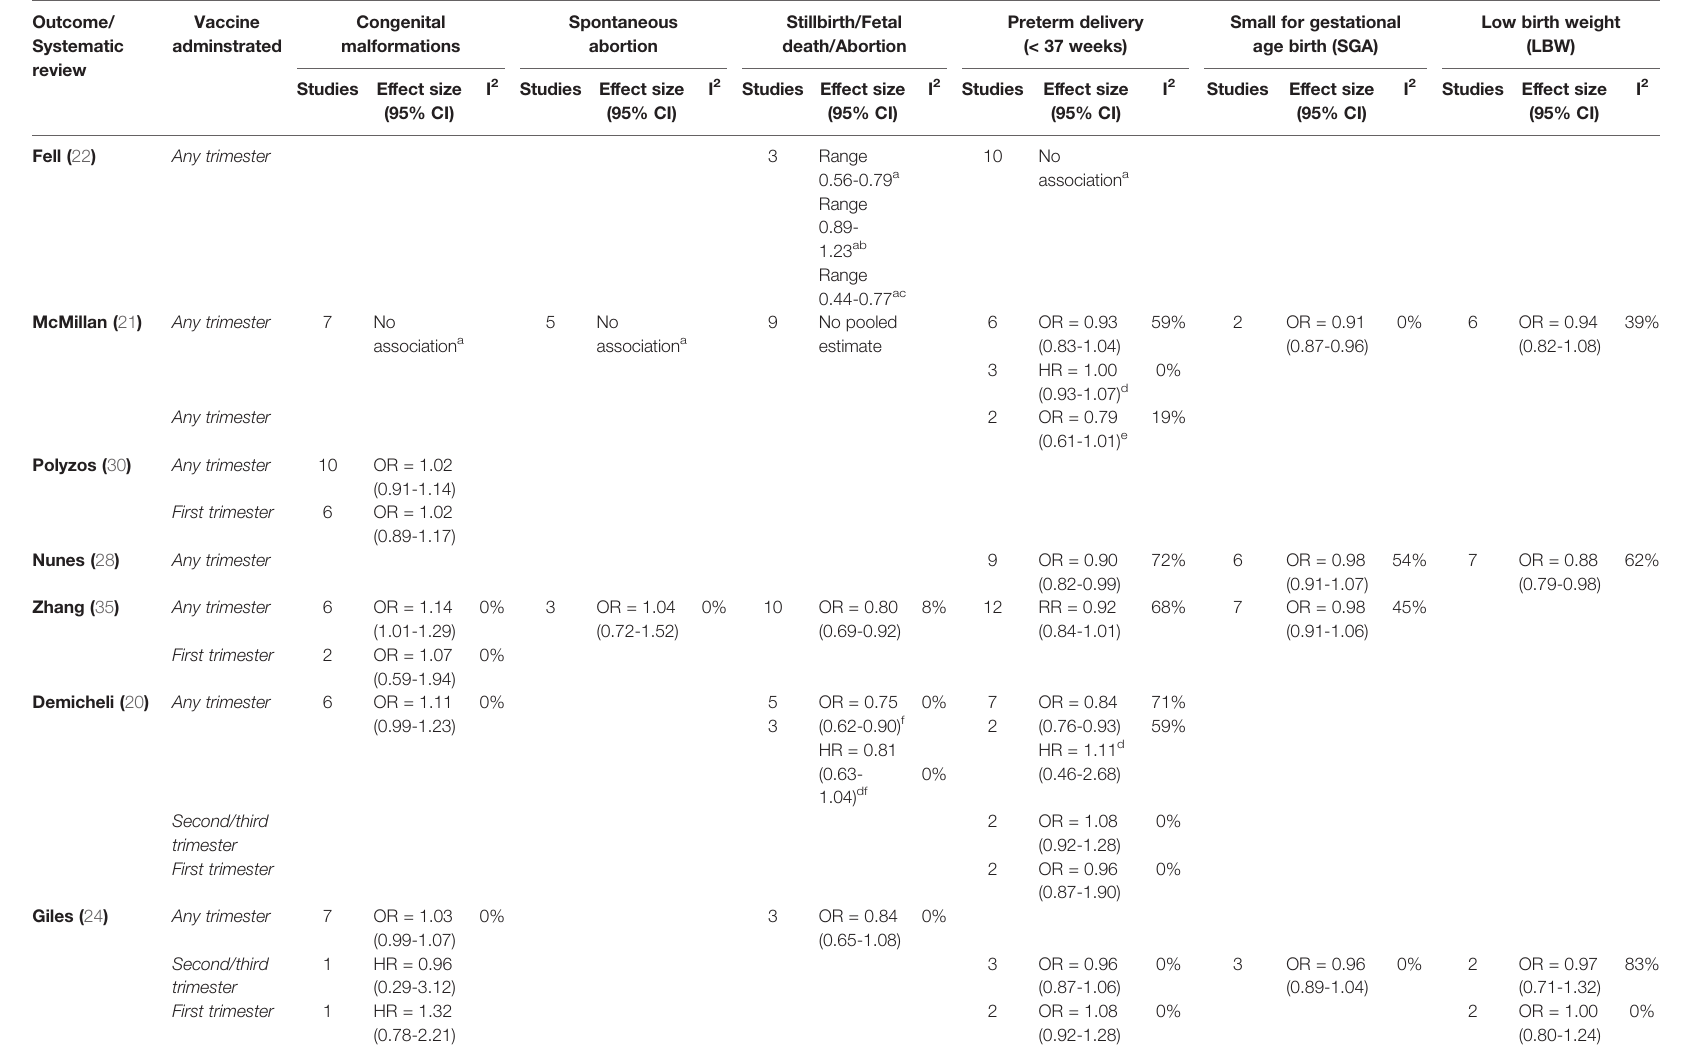
TABLE 5 | Adjusted estimates for fetal outcomes after maternal H1N1pdm09